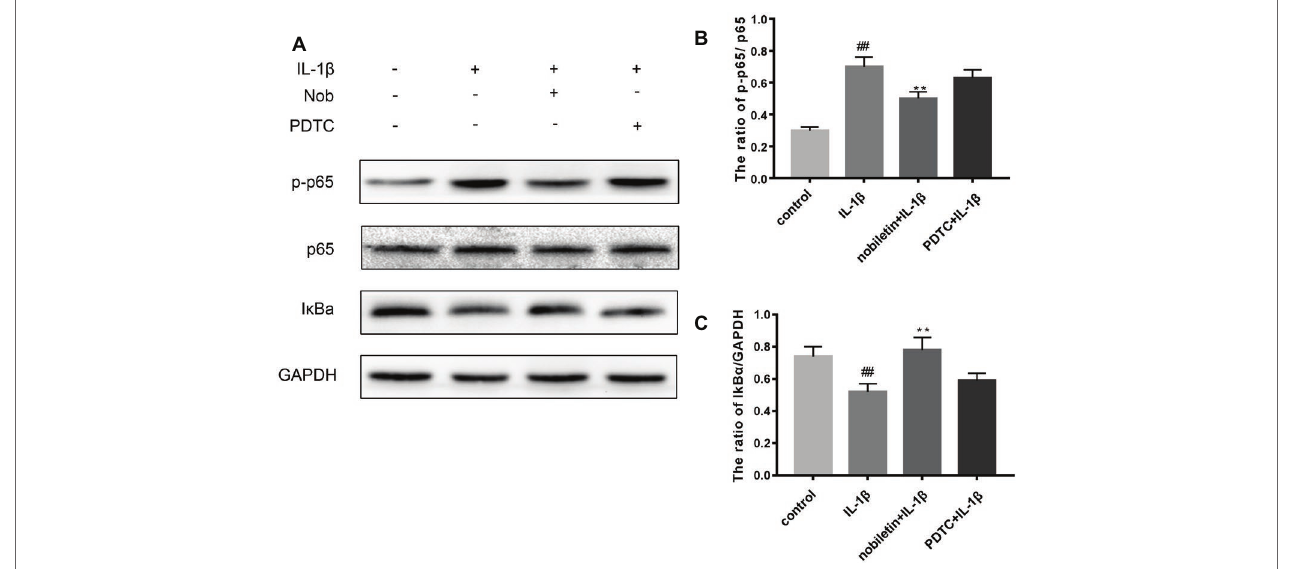
FIGURE 7 | Effects of PBS, IL-1 β , nobiletin with IL-1 β , and PDTC with IL-1 β on the NF-kB signaling pathway. (A–C) IL-1 β significantly increased levels of p-p65 and decreased concentrations of IkBa, an effect which could be partially reversed through the addition of nobiletin or by treatment with PDTC. Values represent